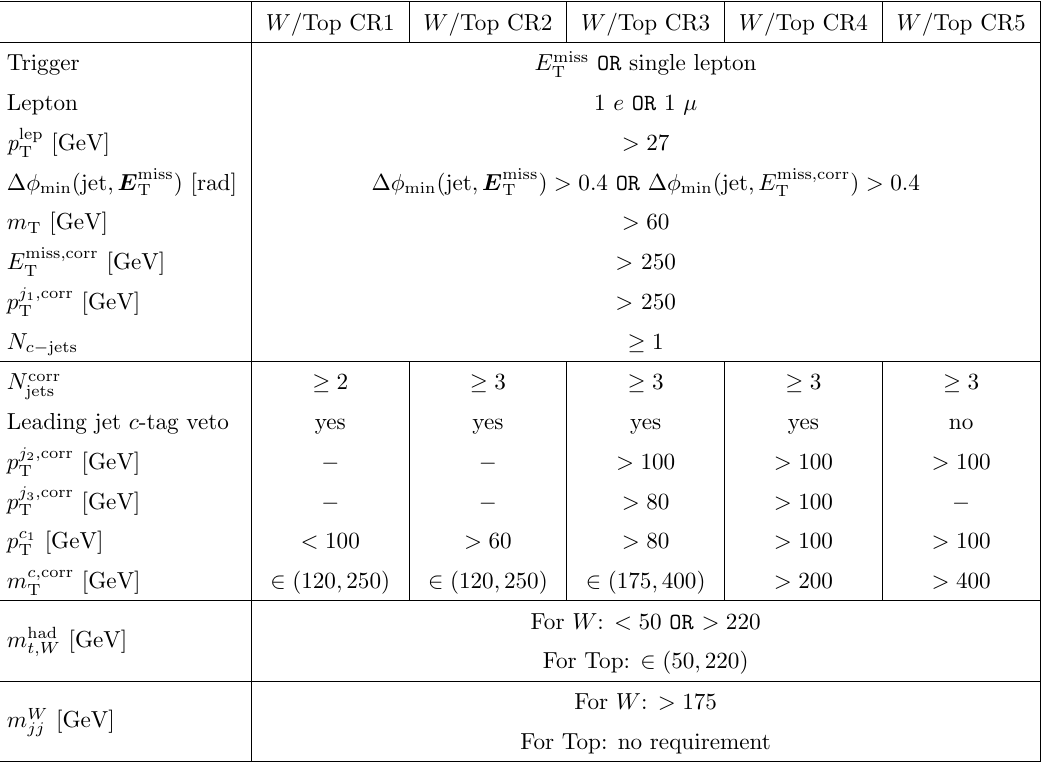
Table 3 . Overview of the W and Top control region selection criteria. N jets and N c (cid:0) jets indicate the total number of jets and c -jets, respectively; p j 1 of the leading, sub-leading and sub-sub-leading jet; and p c 1 c -jet with the highest p T and p lep variables corrected as described in the text.